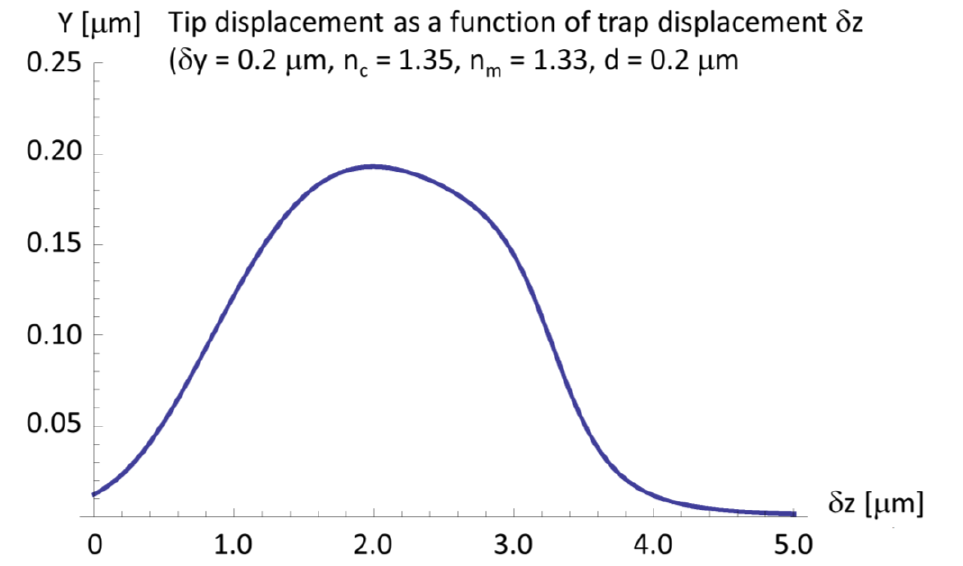
Figure 6. Example deformation of a primary cilium for a representative experiment, showing the effect of varying the vertical displacement of the trap from the cilium base δz. Data graphs the displacement of the cilium tip Y(3) as δz is varied. The trap parameters: incident power P = 0.5 W, trapping lens numerical aperture NA = 0.95, and trap wavelength λ 0 = 1.064 µm. The trap center was displaced from the cilium axis by δy = 0.2 µm. The cilium length is 3.0